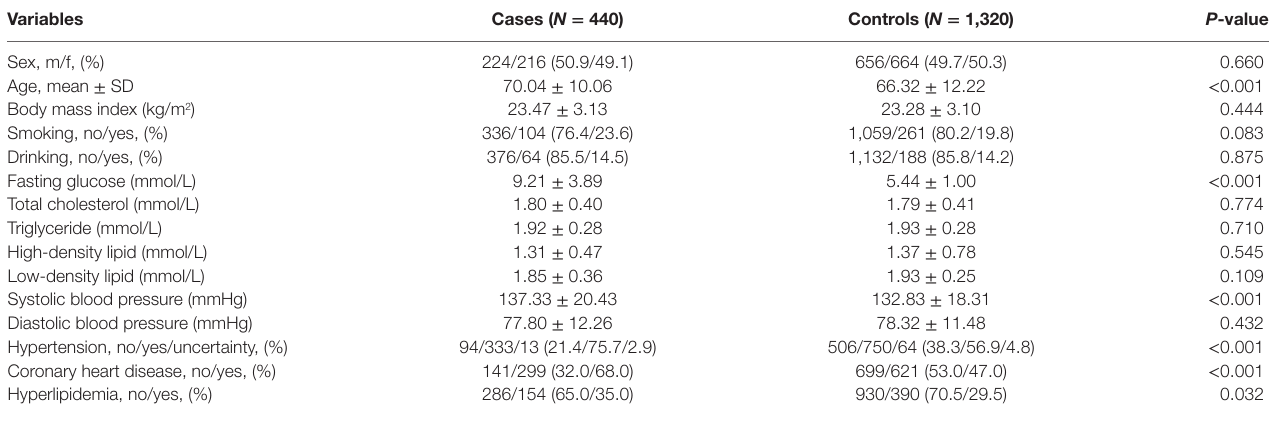
TaBle 1 | Baseline characteristics of type 2 diabetes mellitus cases and non-diabetic controls. Variables cases ( N = 440) controls ( N =